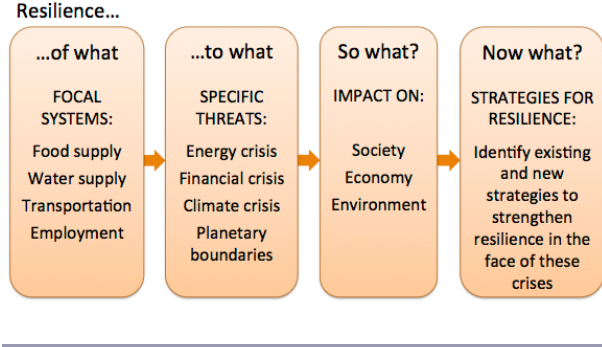
Fig. 3 . The structure and scope of the resilience assessment in Eskilstuna municipality. Developed during the planning meetings with the two strategic environmental planners, Lars Wiklund and Lars-Erik Dahlin, as well as Cathy Wilkinson, Louise Hård af Segerstad, and My Sellberg. The municipality requested the content of the focal systems, specific threats, and impact dimensions. The project manager Cathy Wilkinson set the structure, which was based on the approach of Paul Ryan, an Australian expert practitioner of resilience assessments. The first two steps draw on section 1.1–1.3 in the Resilience Assessment Workbook (Resilience Alliance 2010).